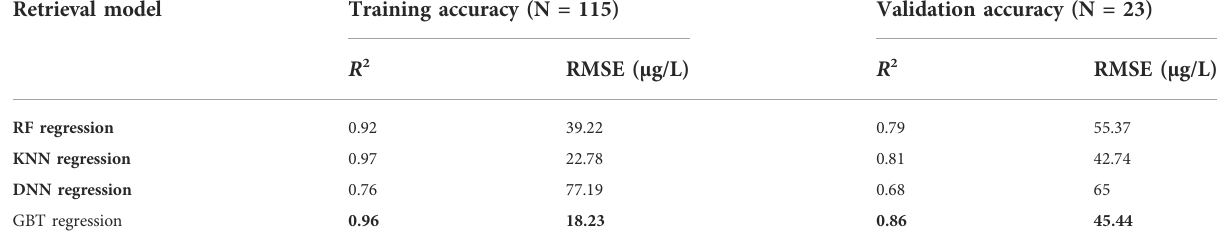
TABLE 4 Accuracy evaluation of PC concentration retrieval models for OLCI